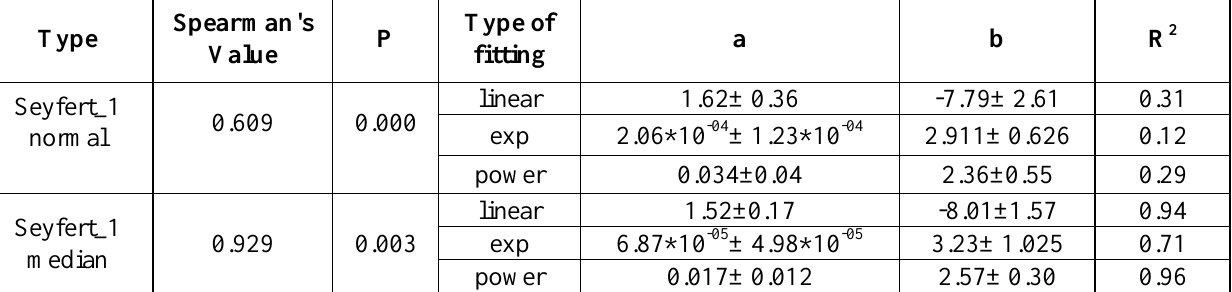
( 𝟏𝟏 ) Table 3: Best fitting parameters for Syfert1 galaxies.